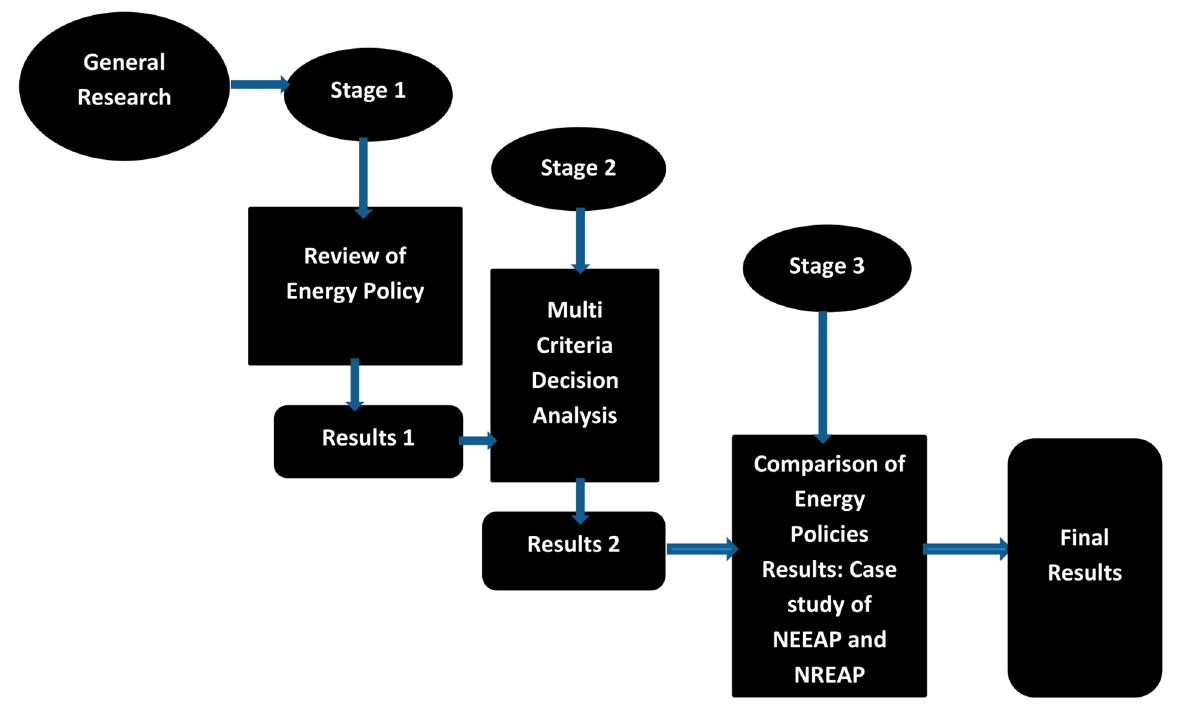
Figure 2. Methodology of the study.